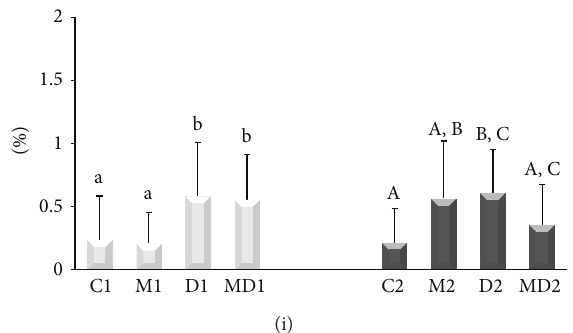
Figure 4: Apoptotic cells quantified by the TUNEL method (brown nuclei). (a) Short-term control (C1); (b) short-term control treated with MLT (M1); (c) short-term untreated diabetic (D1); (d) short-term diabetic treated with MLT (MD1); (e) long-term control (C2); (f) long-term control treated with MLT (M2); (g) long-term untreated diabetic (D2); (h) long-term diabetic treated with MLT (MD2). e: epithelium; l: lumen; s: stroma; arrow: PCNA-positive cells (brown nuclei). Magnification: 400x, bar = 25 𝜇 m. (i) Relative frequency of apoptotic cells (%). Light bars; short-term experiment and dark bars: long-term experiment ( 𝑁 = 5 animals/group). Different lowercase letters indicate significant differences between experimental groups C1, M1, D1, and MD1 (nonparametric data), and different capital letters indicate significant differences between groups C2, M2, D2, and MD2 (nonparametric data), according to ANOVA followed by the Tukey ( post hoc ) or Kruskal-Wallis test followed by Dunn’s test ( post hoc